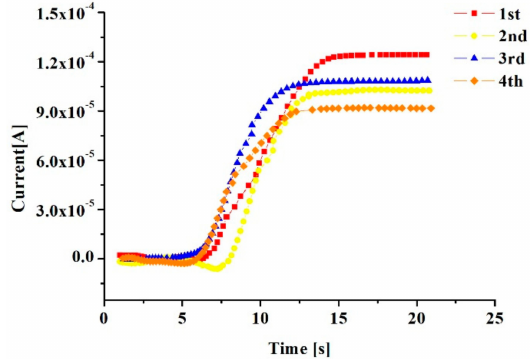
Figure 2. The curve of photocurrent measured in 4